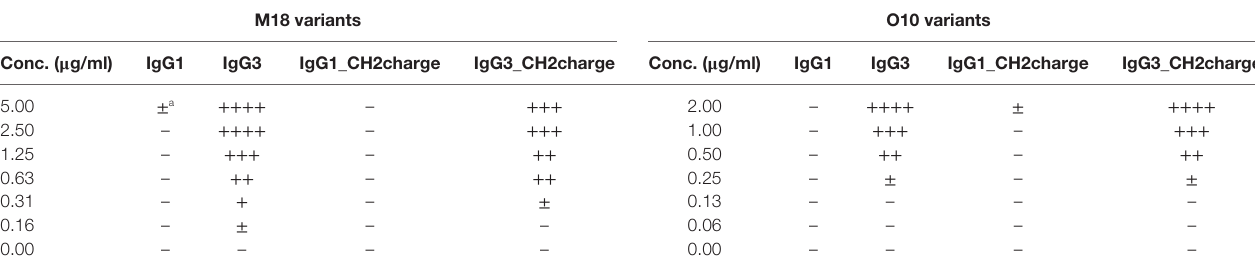
TaBle 5 | Hemagglutination induced by the muteins with modified charge of the CH2